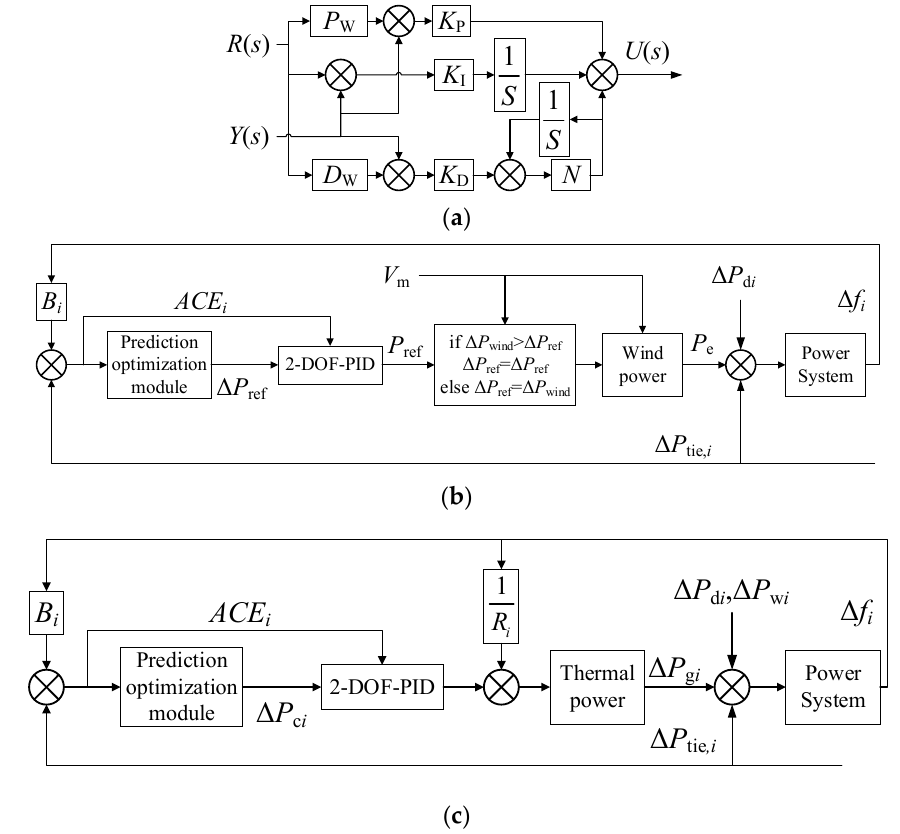
Figure 4. Block diagram of AGC system based on PO-2-DOF-PID controller. ( a ) Conventional 2-DOF-PID controller. ( b ) AGC system with wind power. ( c ) AGC system with thermal power.